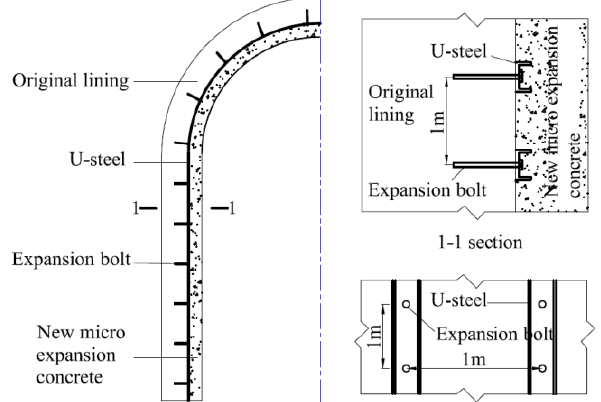
Figure 2. Channel steel reinforcement method.